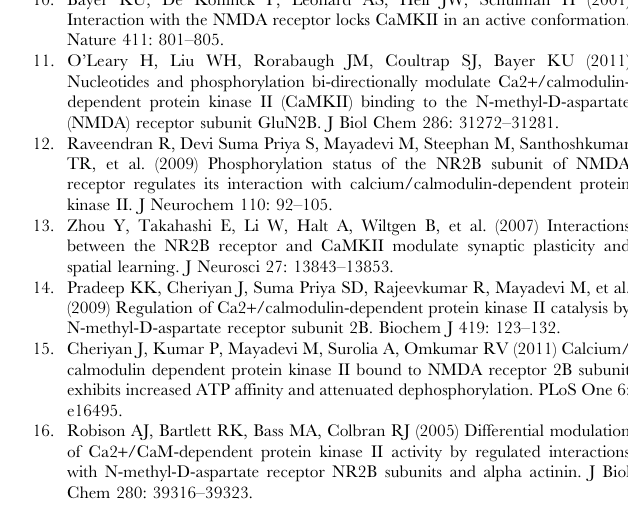
Figure S1 ATP saturation profiles differ among WT, monomeric and heteromeric forms of CaMKII. ATP saturation profiles of phosphorylation of GluN2A and GluN2B by WT (A and B), D 317 (C and D) and Heteromer (E and F) are shown from representative experiments. Three or more such experiments were used in each case to obtain the kinetic parameters shown in Table